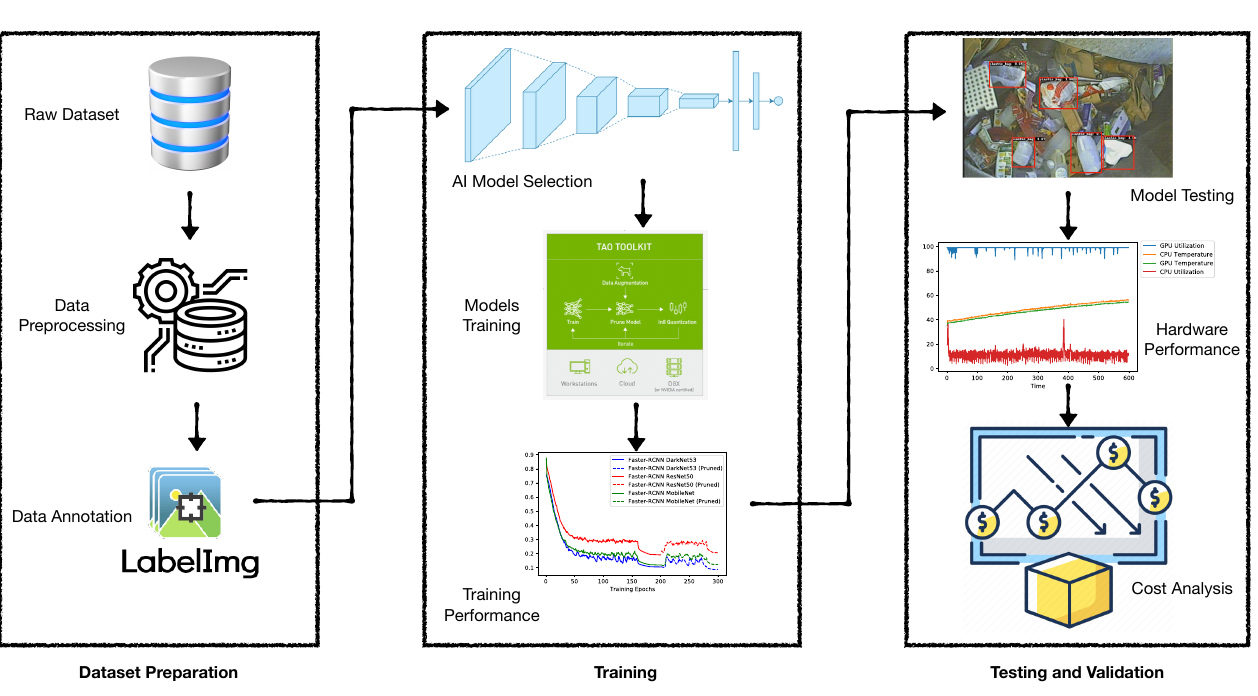
Figure 6. Block diagram representation of the research approach for automated plastic-bag contami- nation